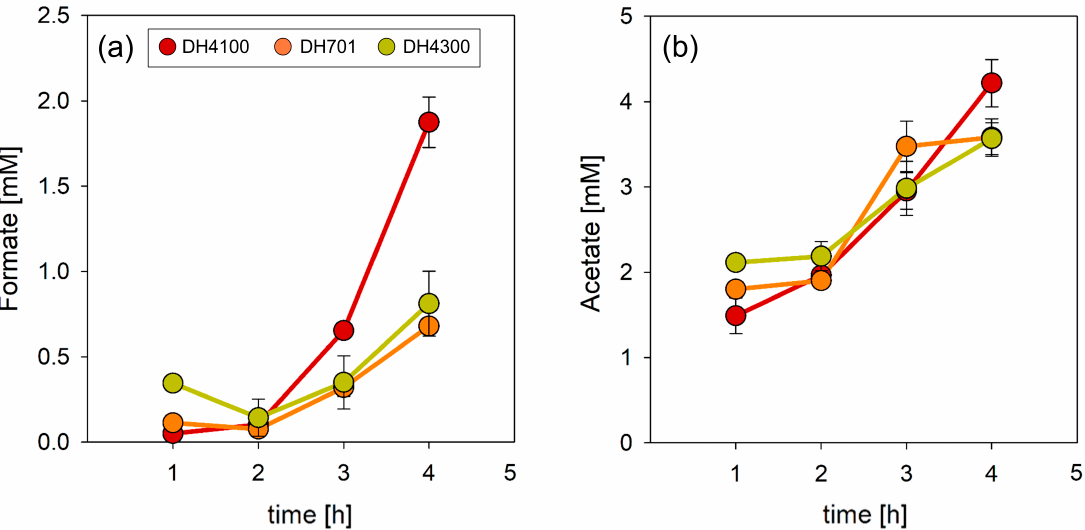
Figure 2. Extracellular formate and acetate concentrations . The formate ( a ) and acetate ( b ) concen- trations in the minimal medium during the fi rst 4 h of growth of the indicated strains (see key within the fi gure) are shown. Strains: DH4100 (red), parental; DH701 (orange), ( focA ); and DH4300 (pale green), synthesizes FocA T91A .